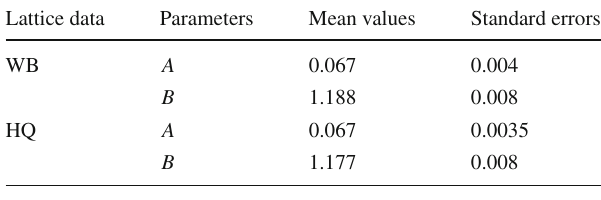
between the coupling strength g ( T ) and the thermal